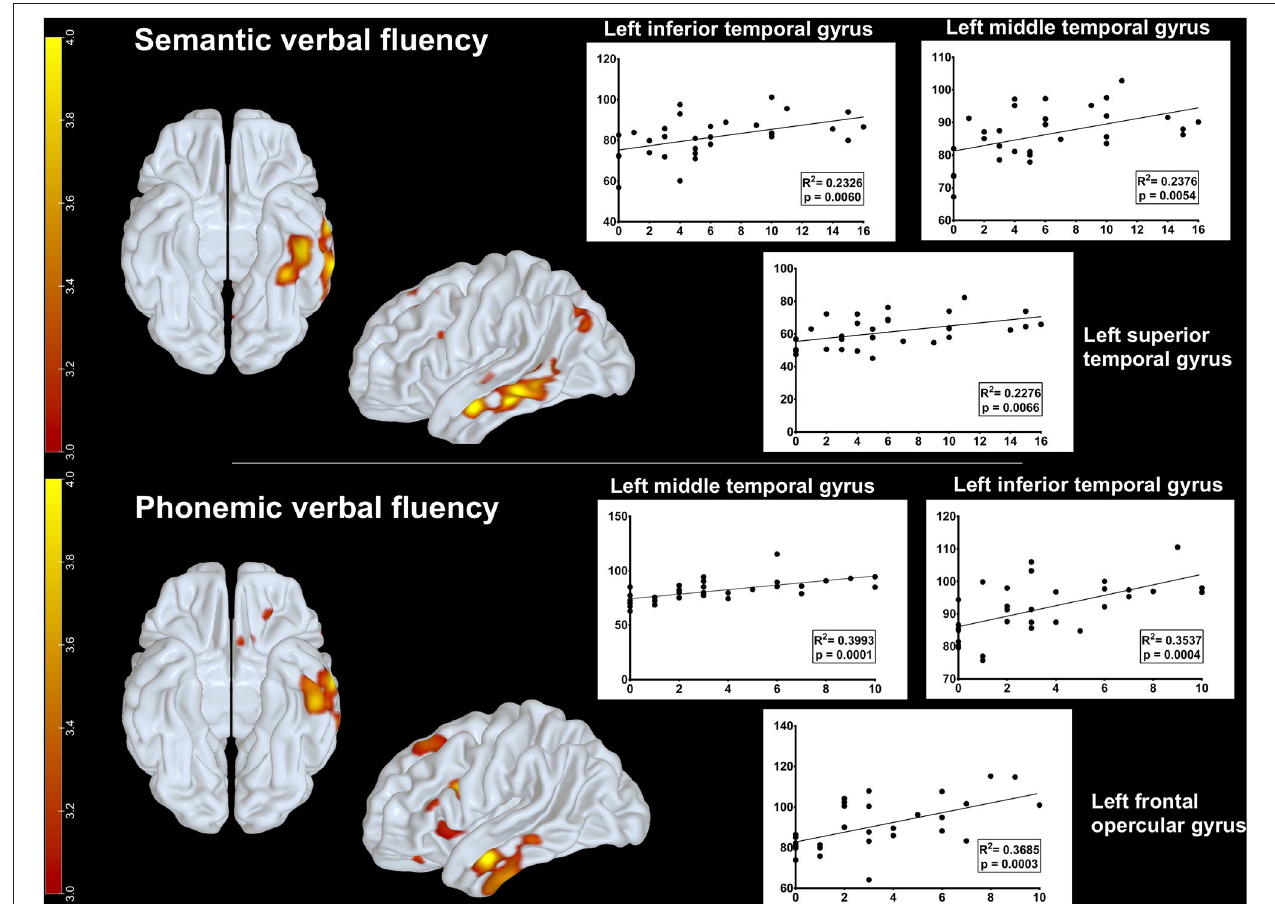
FIGURE 3 | Metabolic correlations between brain regions and verbal fluency tasks. Upper row: positive correlation between glucose uptake on FDG-PET and semantic verbal fluency at the left inferior, middle, and superior temporal gyri. Lower row: positive correlation between glucose uptake on FDG-PET and phonemic fluency at the left frontal opercular gyrus and the inferior and middle temporal gyri. Parametric maps were generated with an unpaired t -test (threshold: p < 0.001, uncorrected) in the SPM8 software and plotted on surface maps with the Surf Ice software http://www.nitrc.org/projects/surfice/). Bars in the left side indicate z scores, ranging from p = 10 − 3 ( z -score = 3.0) to p = 10 − 4 ( z -score =